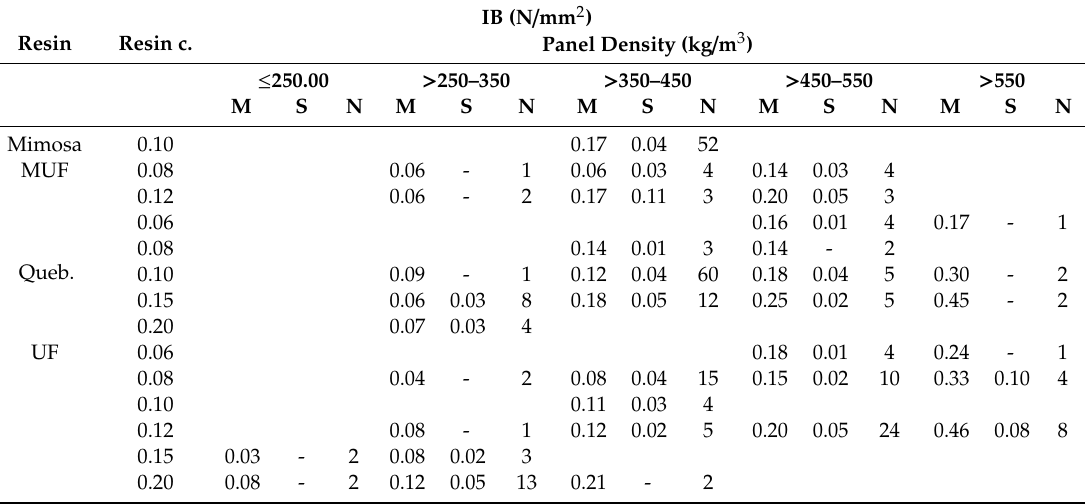
Table 4. IB of panels with varying resin types and